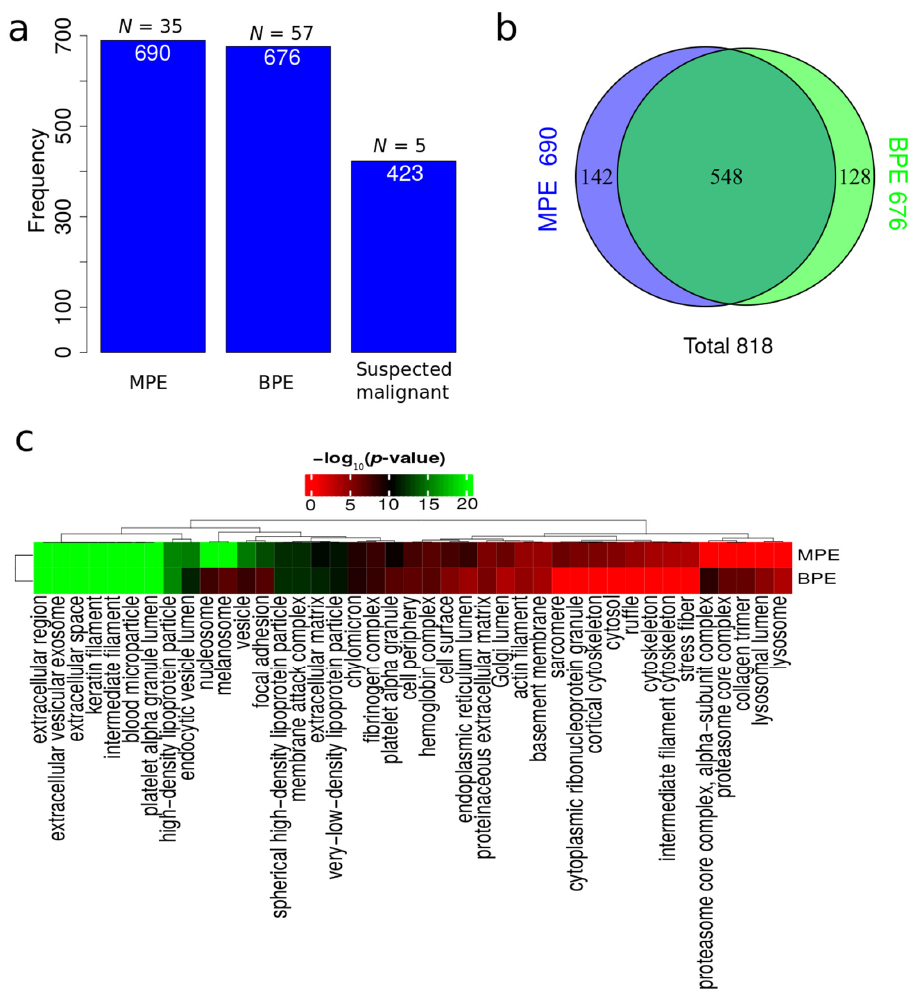
Figure 2. Summary analysis of identified proteins. ( a ) Total number of proteins identified in MPE, BPE and suspected malignant. ( b ) Venn diagram of identified proteins in MPE and BPE. ( c ) Functional enrichment analysis of cellular components based on all identified proteins in MPE and BPE.